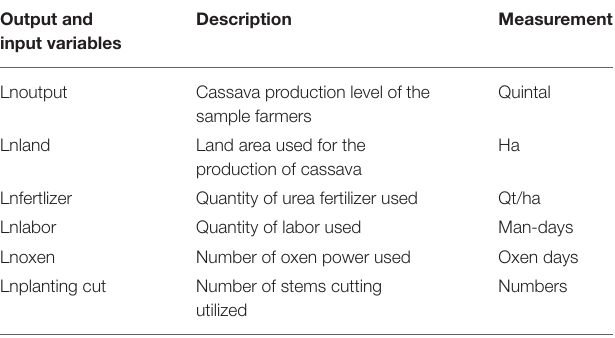
TABLE 2 | The description and measurement of output and input variables